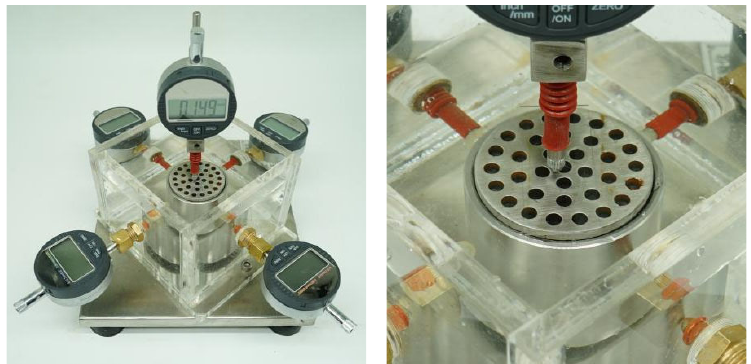
Figure 5. YS ‐ II rock ‐ swelling ratio setup with metal limit. Figure 5. YS-II rock-swelling ratio setup with metal